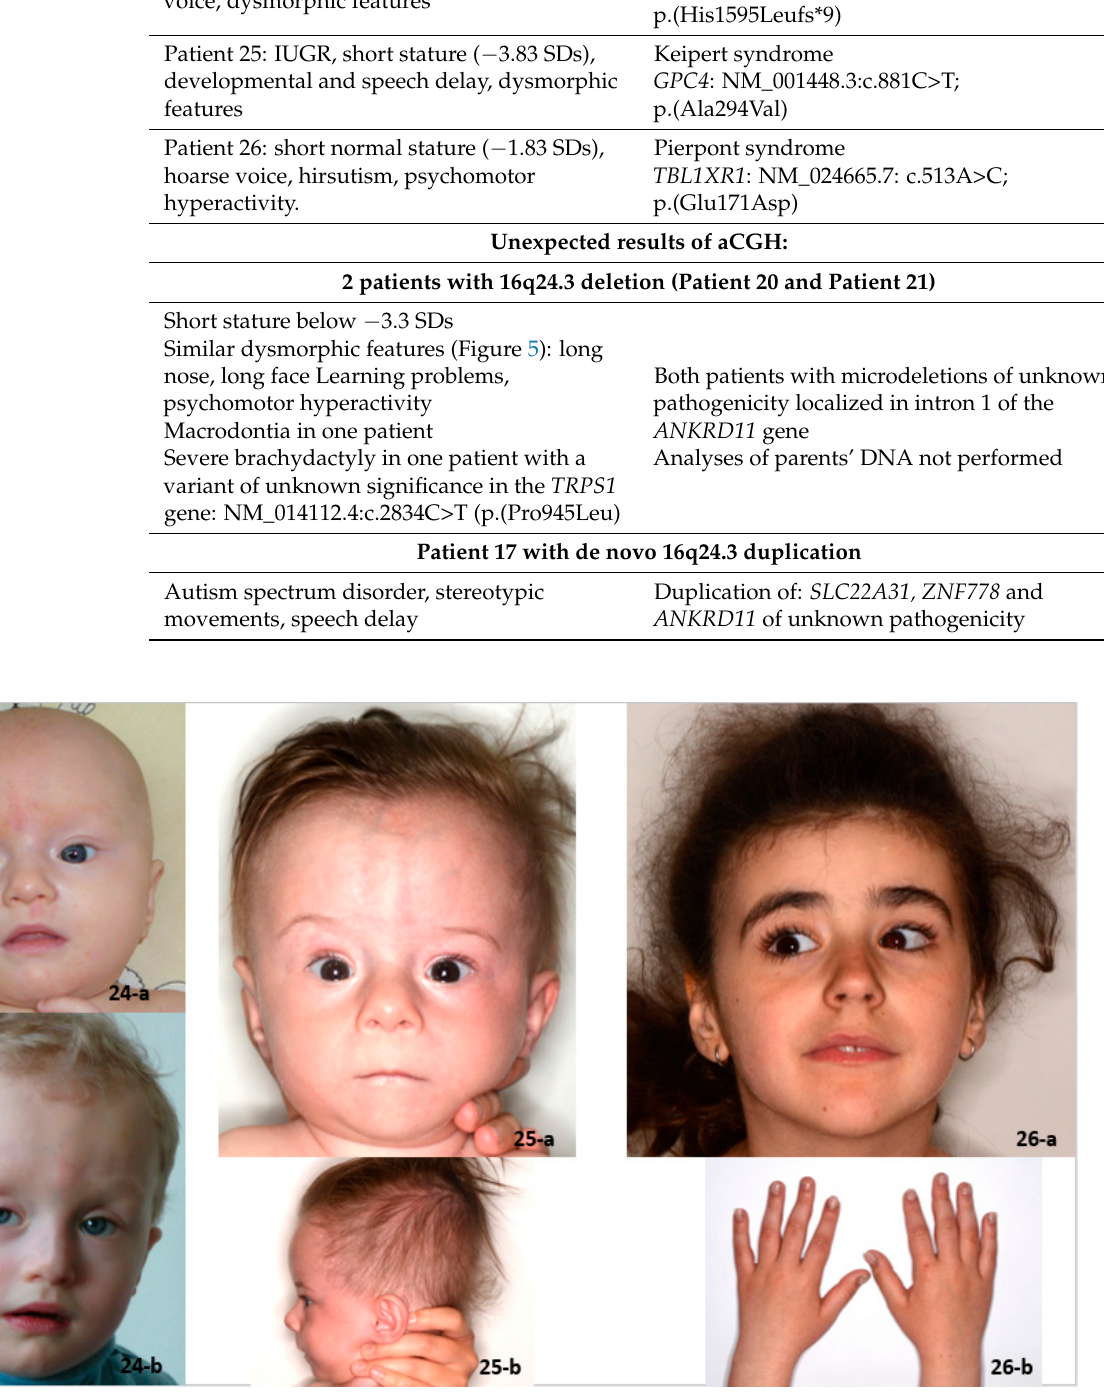
Figure 4. Facial features of patients suspected to have KBG syndrome without ANKRD11 mutations: Patient 24-a,b— Weiss-Kruszka syndrome; Patient 25-a,b—Keipert syndrome; and Patient 26-a,b—Pierpont syndrome. In all patients, note the elongated palpebral fissures and short nose, which were the bases of KBG syndrome suspicion, apart from other clinical signs.